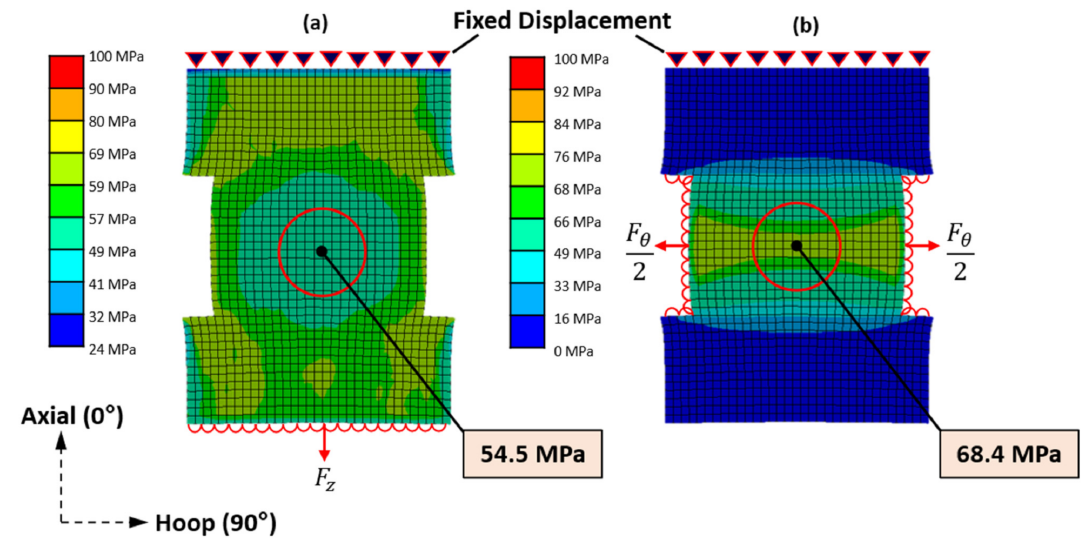
Figure 7. Finite element analysis (FEA) of a composite specimen with normal stresses applied in the ( a ) axial and ( b ) hoop